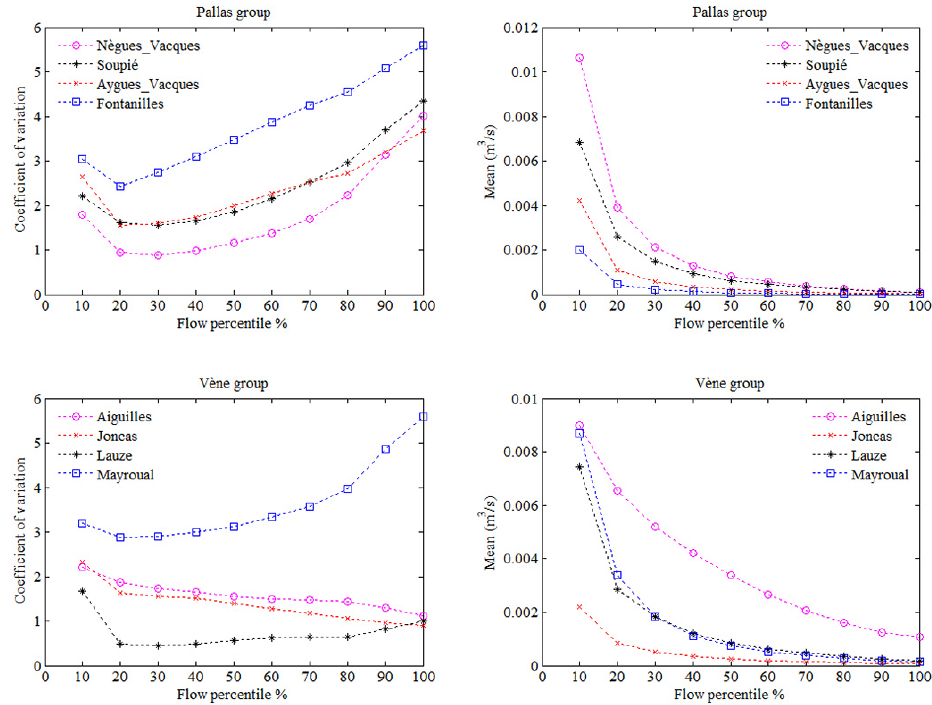
Figure 6. Mean and coefficient of variation of the predicted FDC percentiles based on the physical similarity approach for the Pallas catchment group (Pallas) and for the Vène catchment group (Vène).